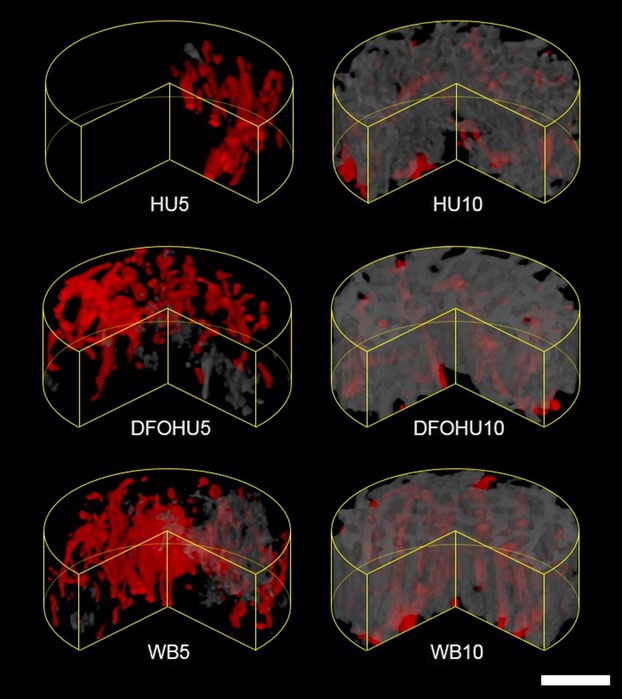
Volume-renderings of blood vessels (red) and bone (gray) within a defect region for each group. The anterior quarter sector was cut from each cylindrical region of interest to make the inner region more visible. Both bone formation and vascularization were considerably suppressed in HU5. Woven-like bone structures were observed in HU10, but comprising a larger number of small-sized bone segments compared with those in DFOHU10 or WB10. Bar: 200 μm.